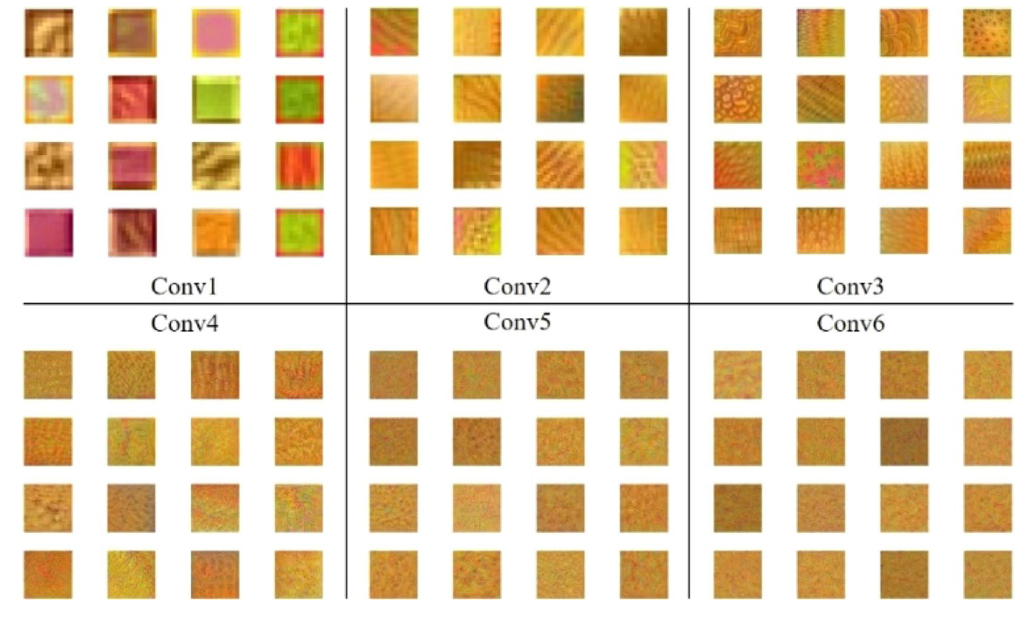
Figure 12. Features captured by our model.